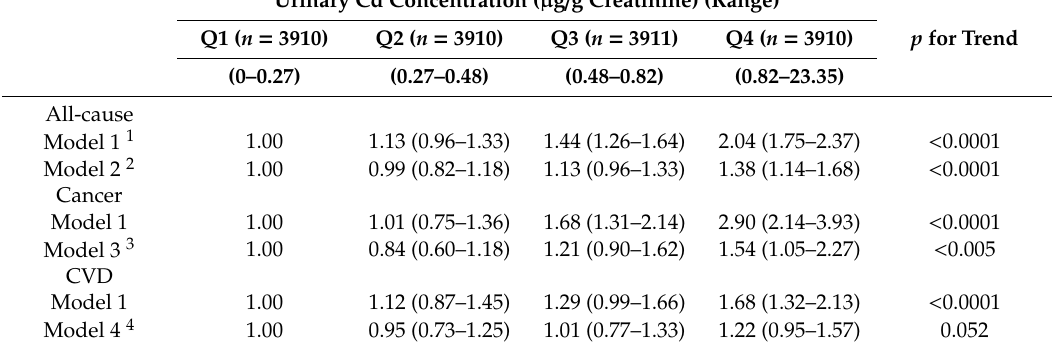
Table 3. Multivariable adjusted HR (95% CI) of all-cause, cancer and CVD mortality using Cox proportional hazards models among US adults ≥ 30 years old in NHANES 1988–2004 by quartile of urinary Cd concentration ( n = 15,641).